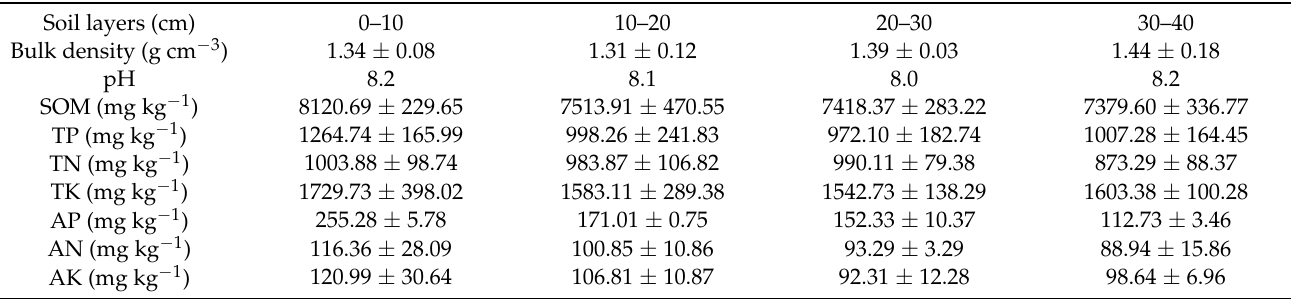
Table 1. The soil bulk density, pH and concentrations of soil organic matter (SOM), total phosphorus (TP), total nitrogen (TN), total potassium (TK), available phosphorus (AP), available nitrogen (AN), and available potassium (AK) (mean ± SD) from different soil layers in the study